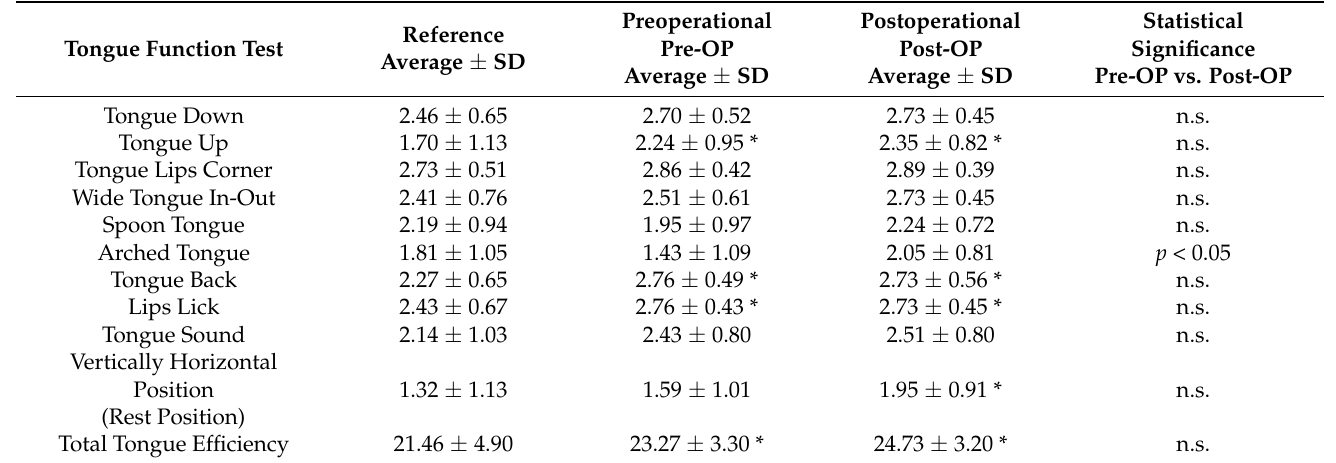
Table 5. Lingual function in operated dysgnathic patients.